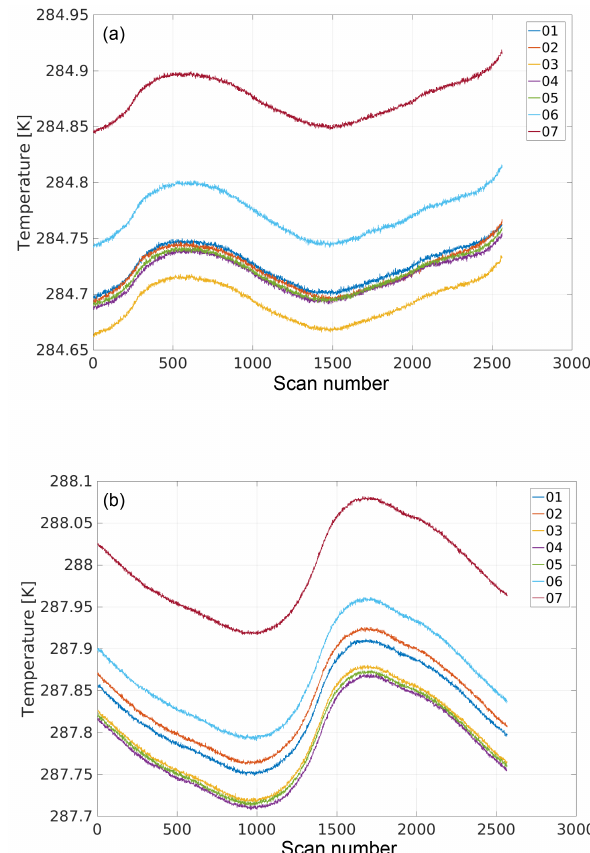
Figure 2. Temperature measured by seven PRTs of the black body of AMSU-B on board NOAA-16 during two orbits 10 years apart: 12 February 2001 (a) and 30 July 2011 (b)